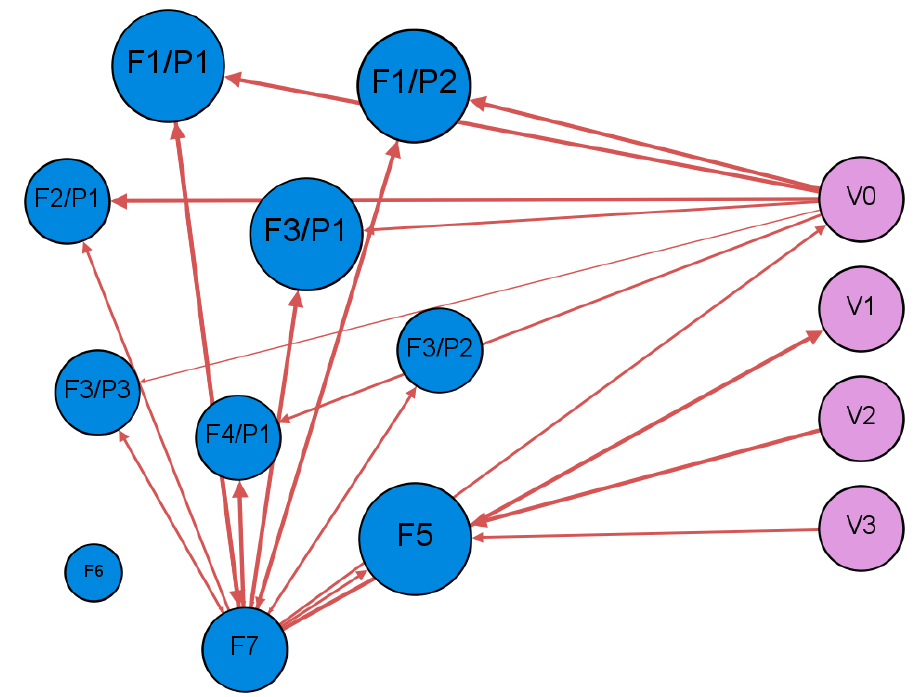
Figure 12. Negative relations that occur between the analysed criteria and decision alternatives according to the assessment of the first expert.